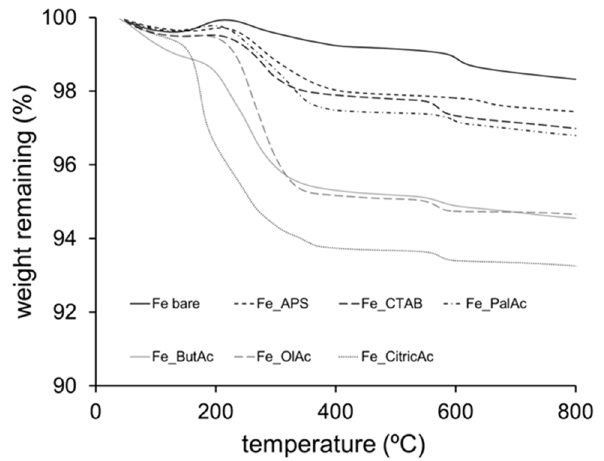
Figure 2. Thermal degradation of bare and functionalised Fe 3 O 4 NPs with APS (Fe-APS), CTAB (Fe-CTAB), palmitic acid (Fe-PalAc), butyric acid (Fe-ButAc), oleic acid (Fe-OlAc), and citric acid (Fe-CitricAc).